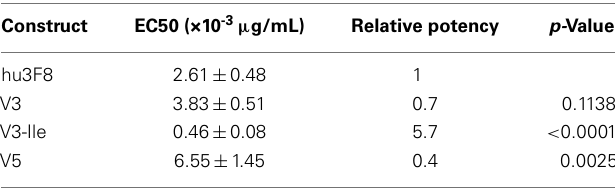
Table 6 |Analysis of in vitro antibody-dependent cell-mediated cytotoxicity of neuroblastoma LAN-1 cells